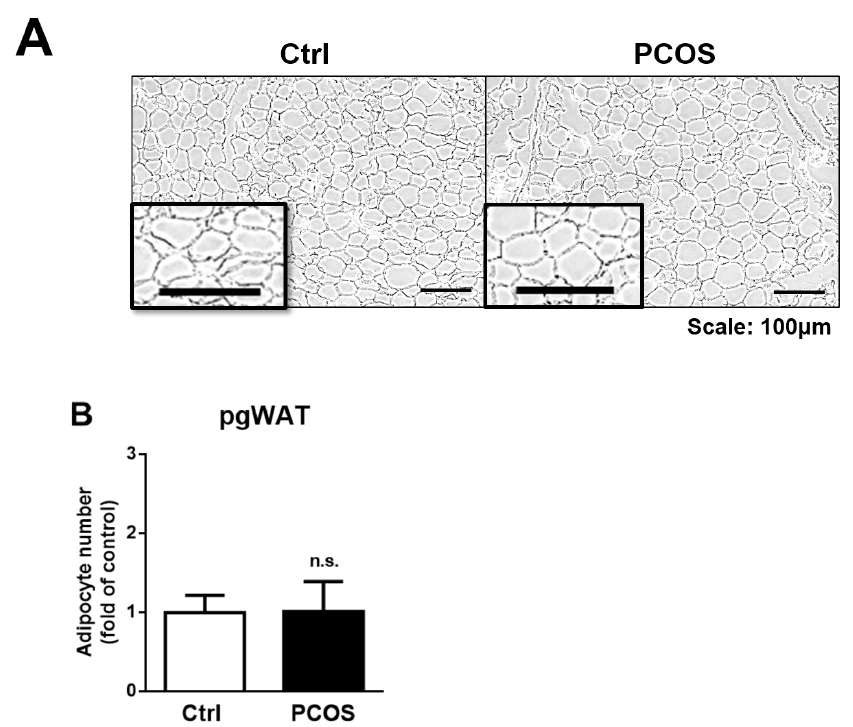
Figure 5. A histological image of the perigonadal white adipose tissue (pgWAT) is shown using H&E staining. Magnification = 400×. The virtual image of the adipose section ( A ) and the quantified result are both shown ( B ). Results are expressed as the mean ± SD. n.s.: not significant.